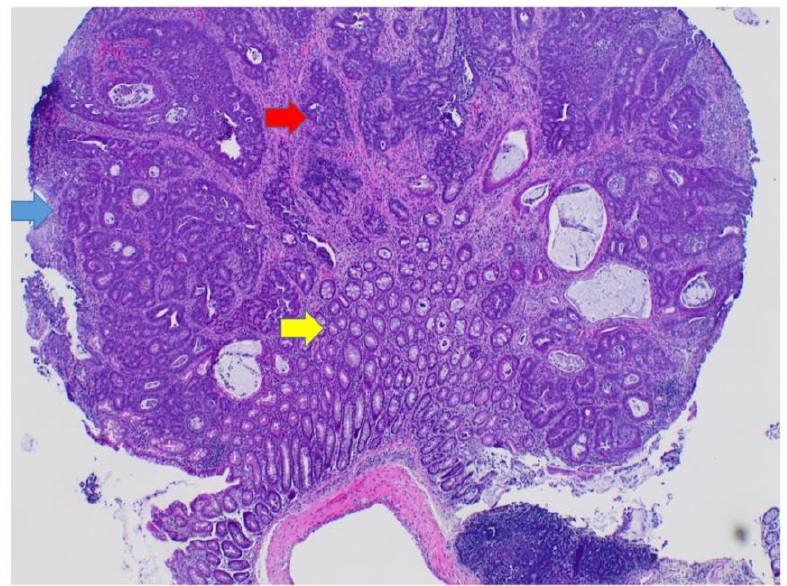
Figure 4. H&E staining demonstrating high-grade dysplasia (blue arrow) and intramucosal adeno- carcinoma (red arrow) within the murine polyp without invasion of the basement membrane. Yellow arrow indicates normal murine colonic tissue.